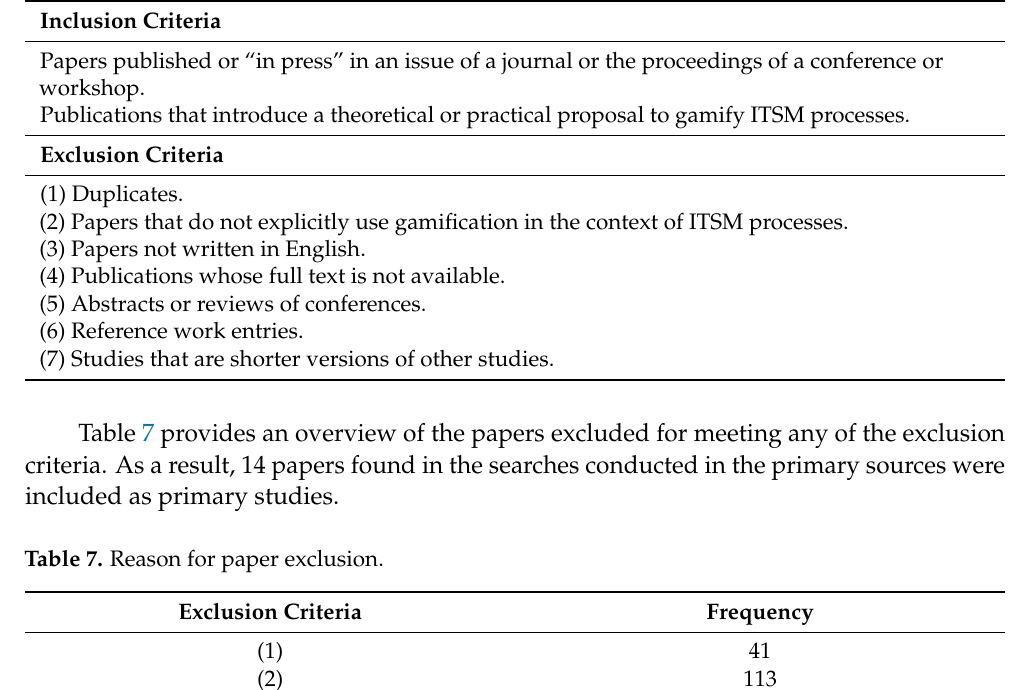
Table 6. Inclusion and exclusion criteria.